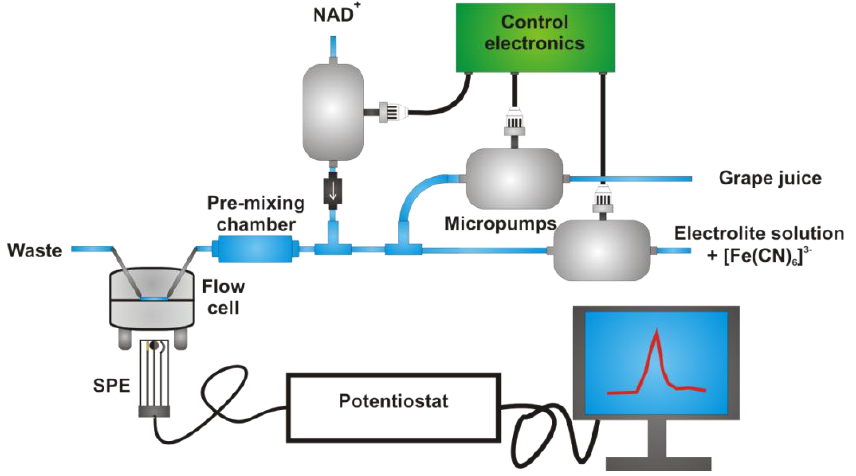
Figure 2. Scheme of the portable and automated instrument for the analysis of